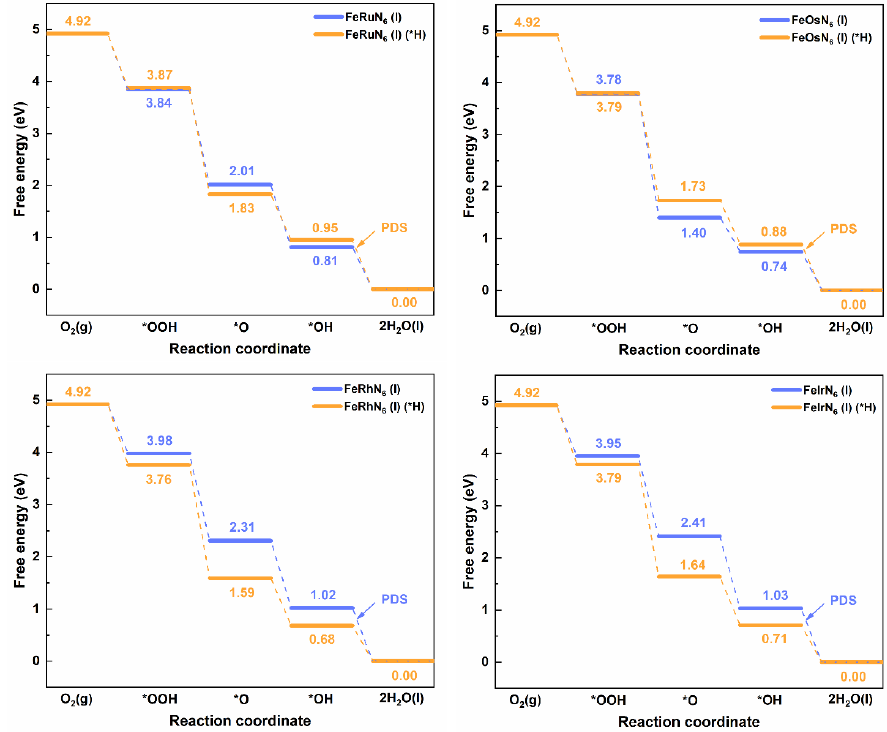
Figure 7. The free energy diagram of FeRuN 6 (I), FeOsN 6 (I), FeRhN 6 (I), and FeIrN 6 (I) with and without protonation.